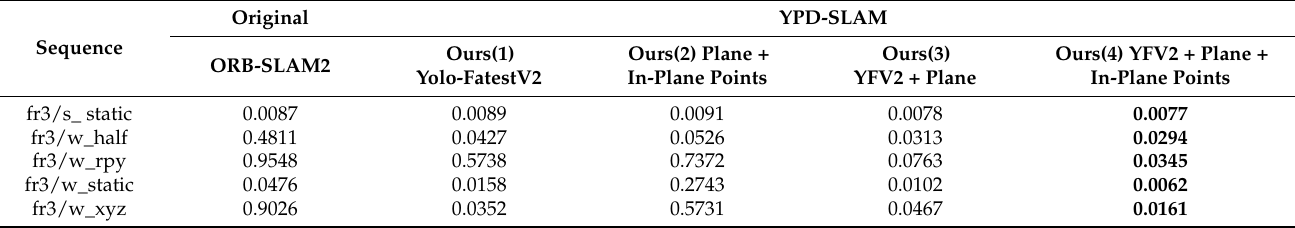
Table 4. For the TUM dataset, different algorithms are composed to obtain the RMSE of